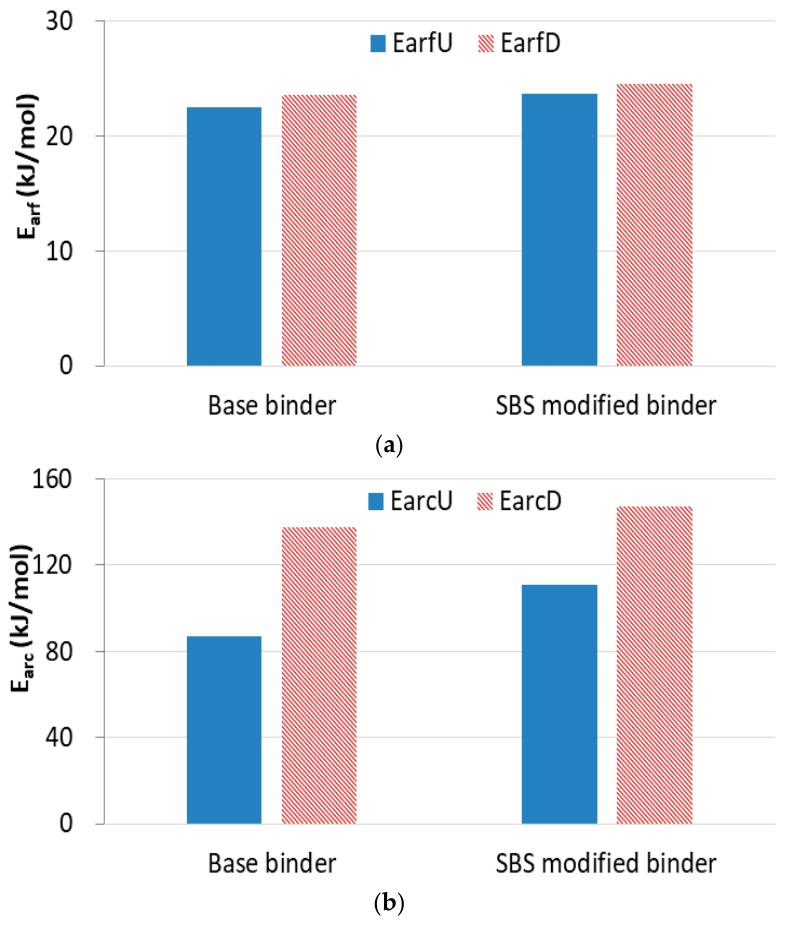
Figure 9. Recovery activation energy of base binder and SBS modified binder. ( a ) Fast-rate recovery activation energy; ( b ) Constant-rate recovery activation energy.